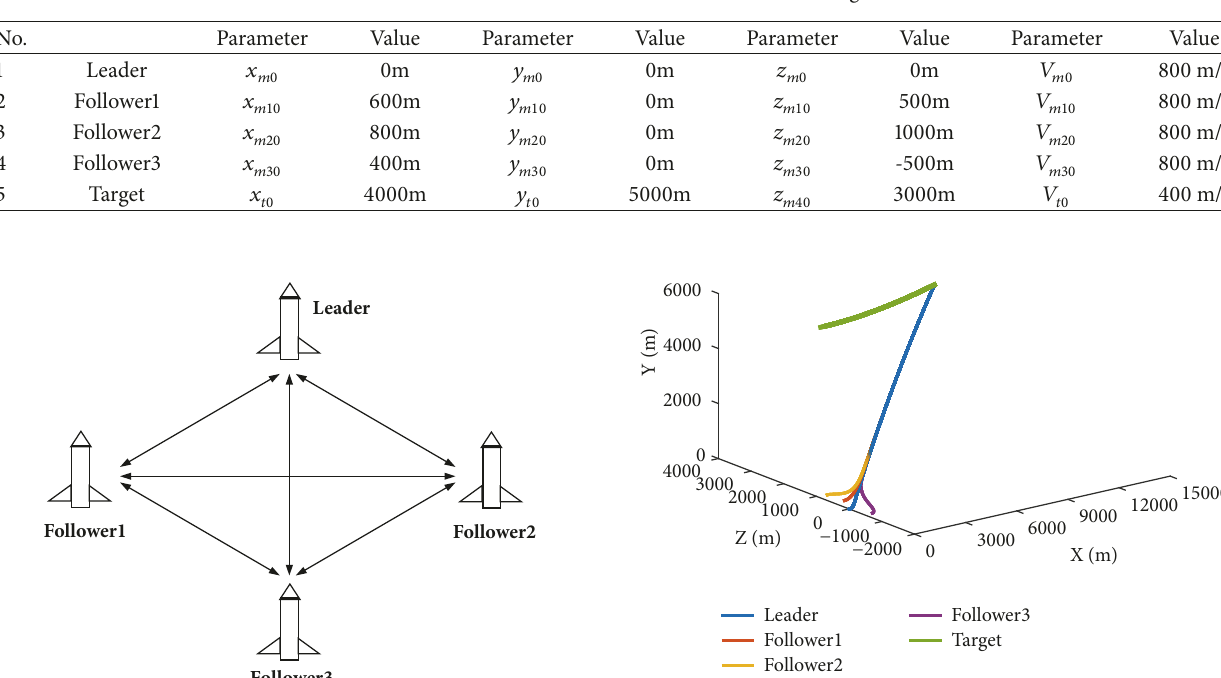
Table 1: Initial conditions of the leader, follower, and target.